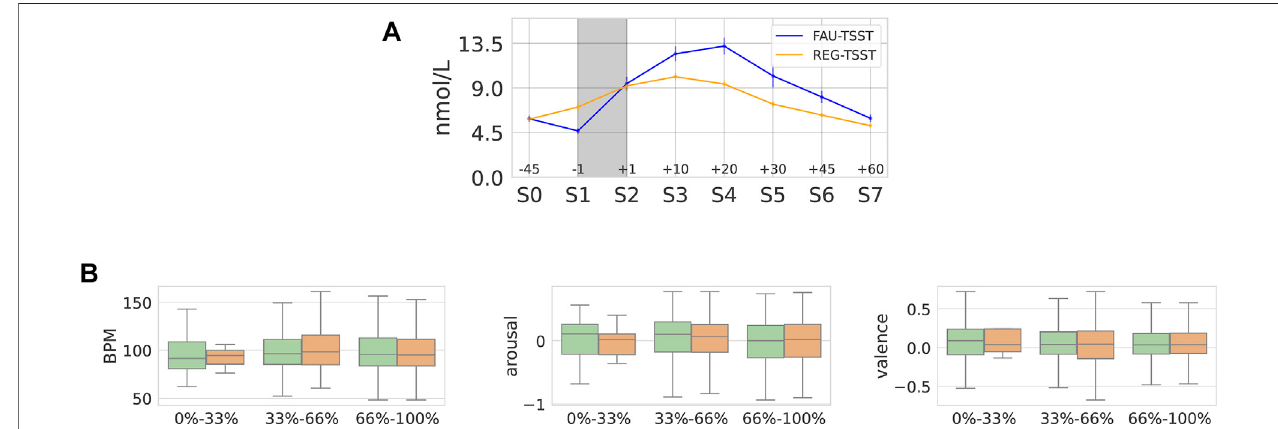
FIGURE 9| The mean ( μ ) predicted cortisolvalue for each timestep on the ULM-TSST dataset using models built on FAU-TSST and REG-TSST (above).Below, is the BPM, arousal and valence predictions grouped based on raw cortisol (nmol/L), obtained for time point S4 using models built on FAU-TSST (left-green) and REG-TSST (right- orange) . Low, mid, and high groupings de fi ned separately for each dataset based on percentiles. (A) U LM -TSST μ cortsiol in nmol/L. (B) Cortisol groups for BPM, arousal, and valence predictions of FAU-TSST (left-green) and R EG